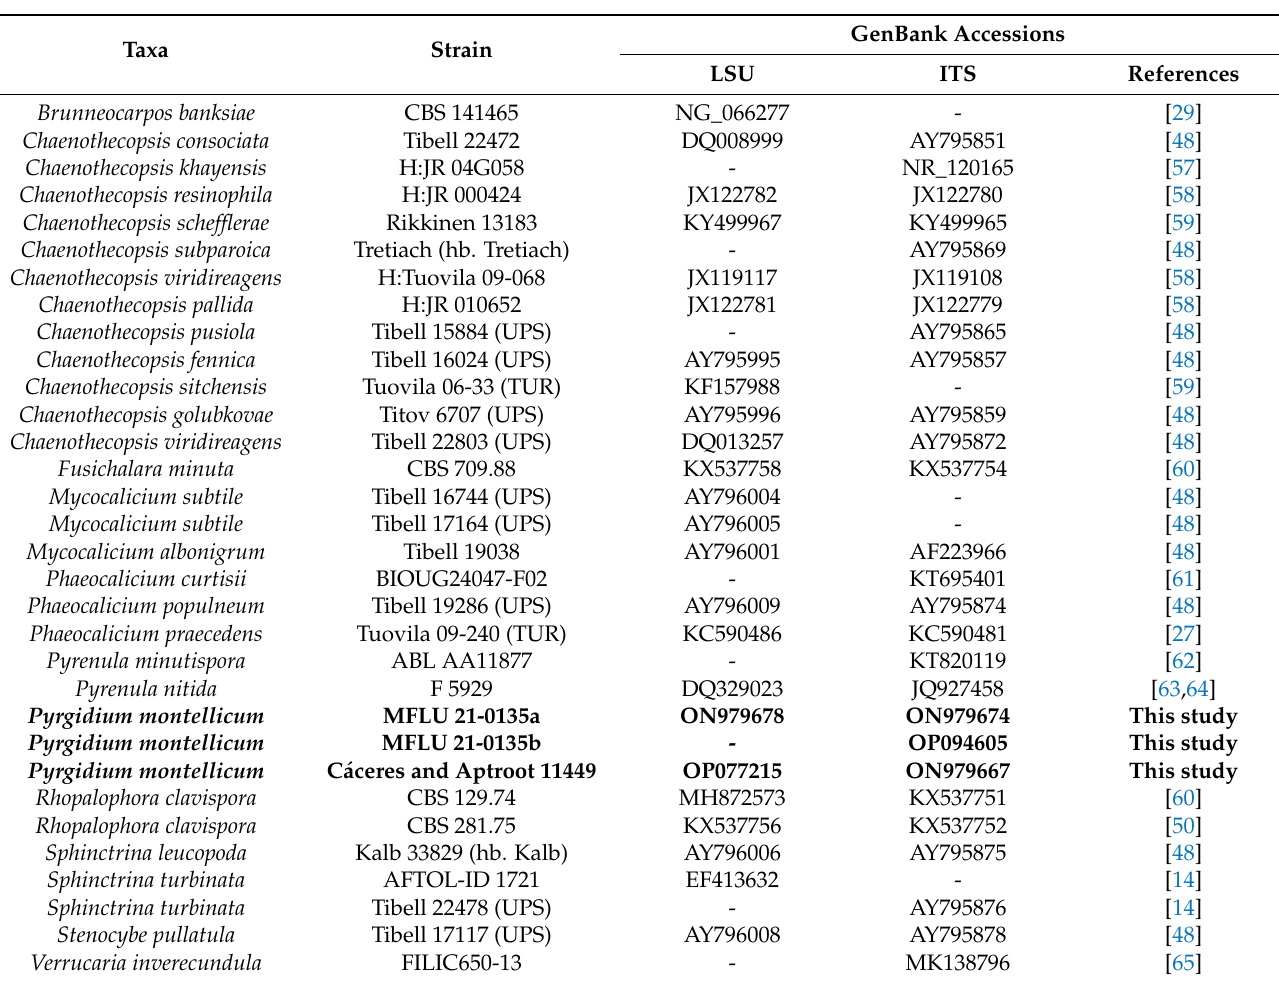
Table 2. Taxa names, strain numbers and corresponding GenBank accession numbers of the LSU and ITS sequences used in the phylogenetic analyses. The newly generated sequences are shown in bold